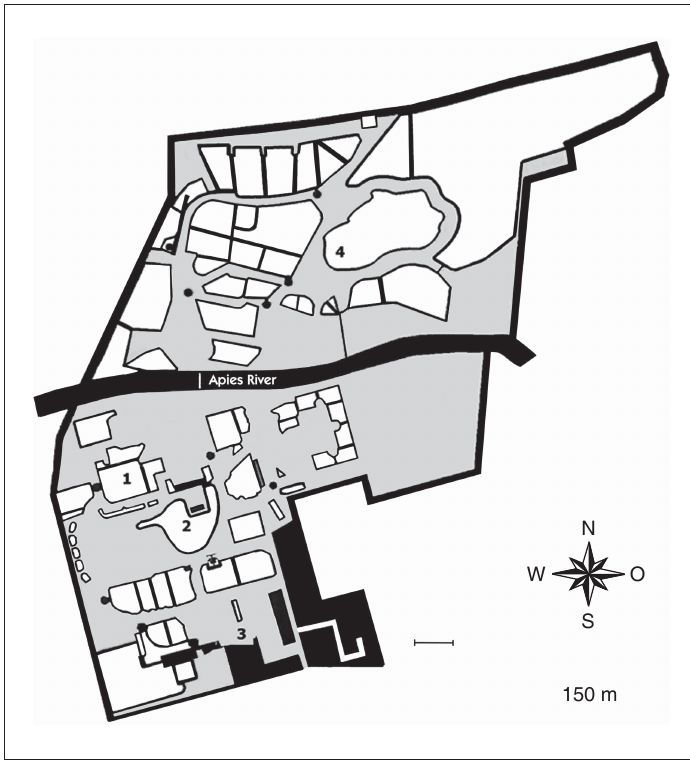
FIG. 1 Plan of the National Zoological Gardens of South Africa, Pretoria, South Africa showing placement of light traps. (1) Cape buffalo enclo- sure, (2) African elephant enclosure, (3) walk-through aviary and (4) white rhinoceros/black-faced impala